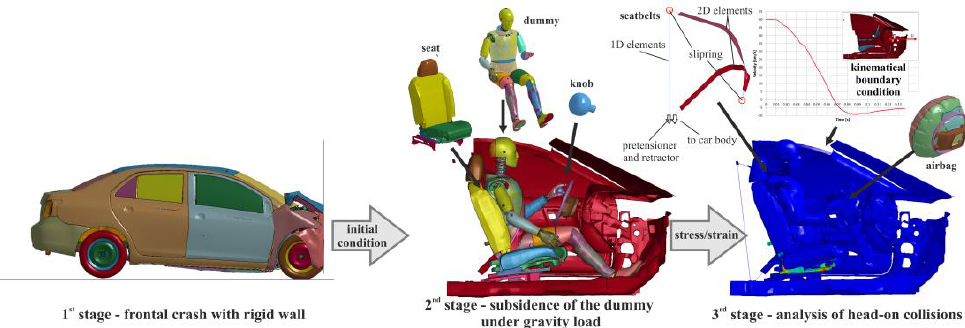
Figure 1. Numerical research strategy [21] (with permission of Editor in Chief of Acta of Bioengineering and Biomechanics).